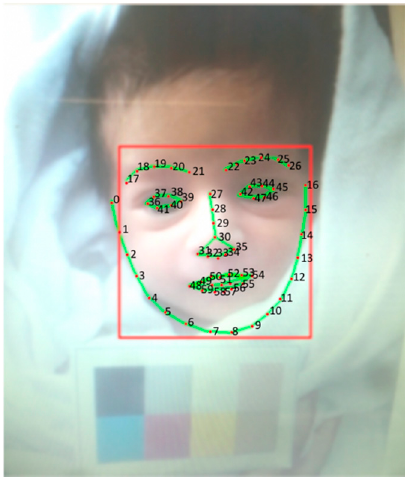
Figure 3. Face landmarks detection.